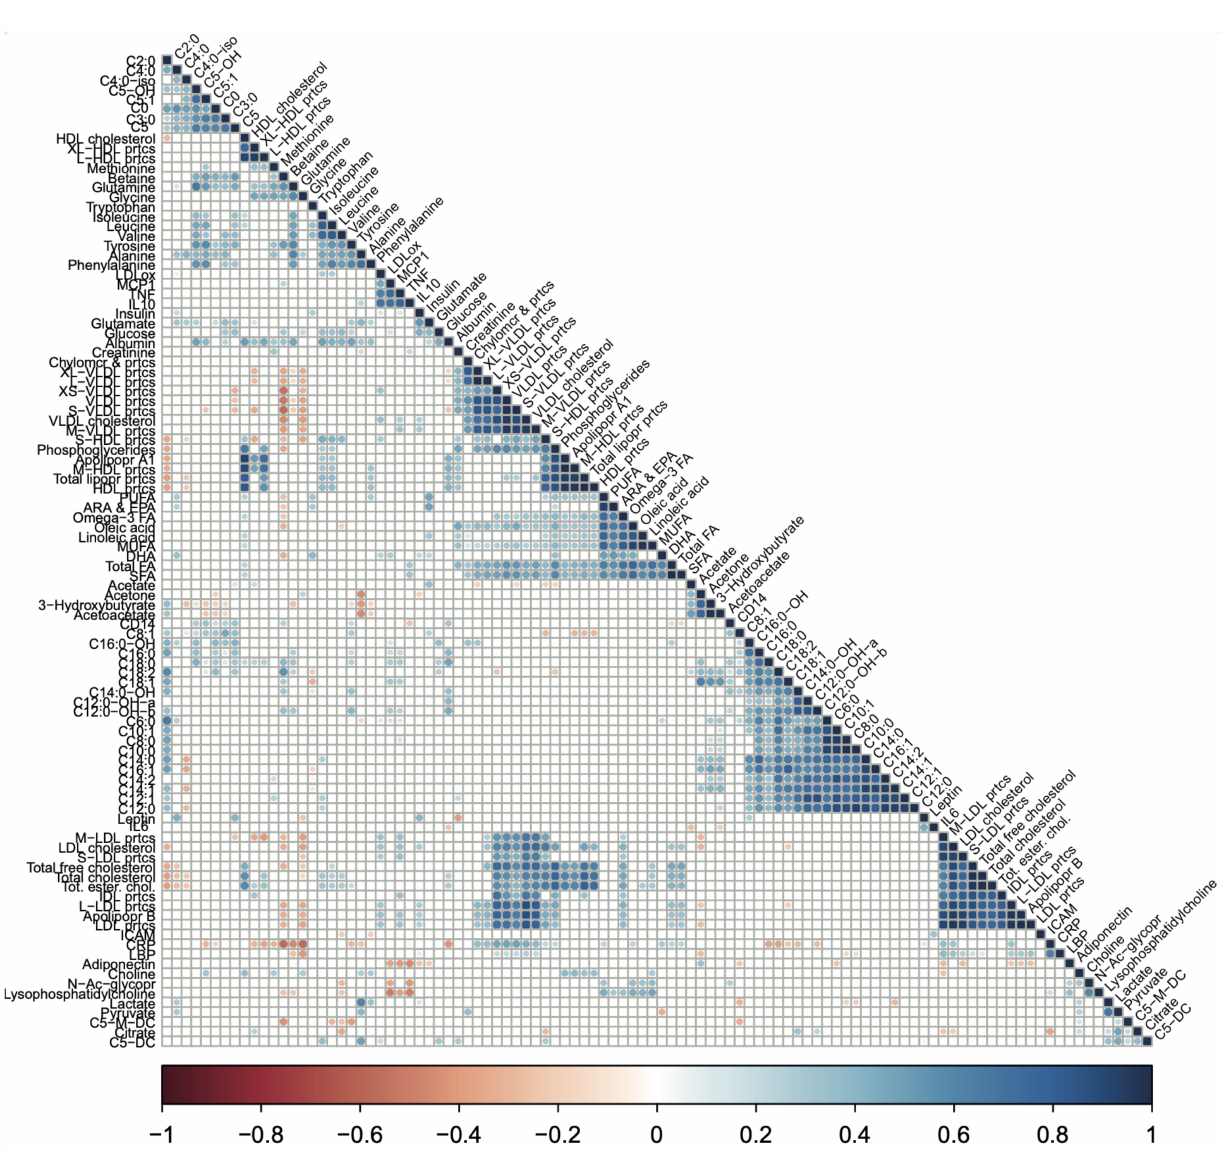
Figure 5. A correlation matrix showing the relationships between biomarker and metabolic parameter pairs. The correlation matrix based on Spearman correlation coefficients between biomarker and metabolic parameters pairs. Spearman rank correlation analysis was performed on the scaled biomarker and metabolic parameters values for all biomarker and metabolic parameters pairs using the combined data of high-fit and low-fit females at baseline and post-exercise. Relationships were considered statistically significant when p < 0.05. Significant relationships are indicated in red (negative correlation) or blue (positive correlation). Non-significant relationships ( p > 0.05) are left